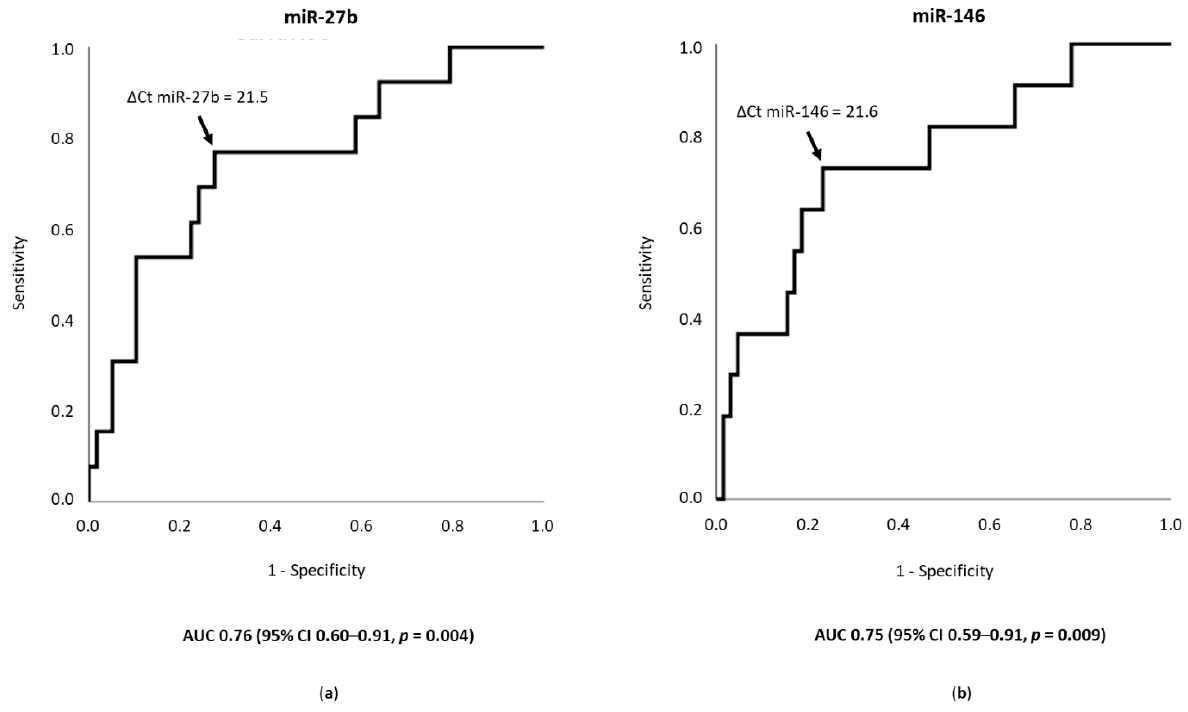
Figure 2. Accuracy of miR-27b and miR-146 as predictors of polyvascular atherosclerosis. The receiver operating charac- teristics curve is presented for ( a ) Δ Ct miR-27b and ( b ) Δ Ct miR-146, as predictors of polyvascular atherosclerosis involv- ing the coronary, lower extremity, and carotid territories. The optimal cut-off for ( a ) Δ Ct miR-27b was 21.5 and for ( b ) Δ Ct miR-146 was 21.6, presenting a Youden’s index [25,26] of 0.49 and 0.50, respectively. 95% CI—95% confidence interval; AUC—area under the curve.